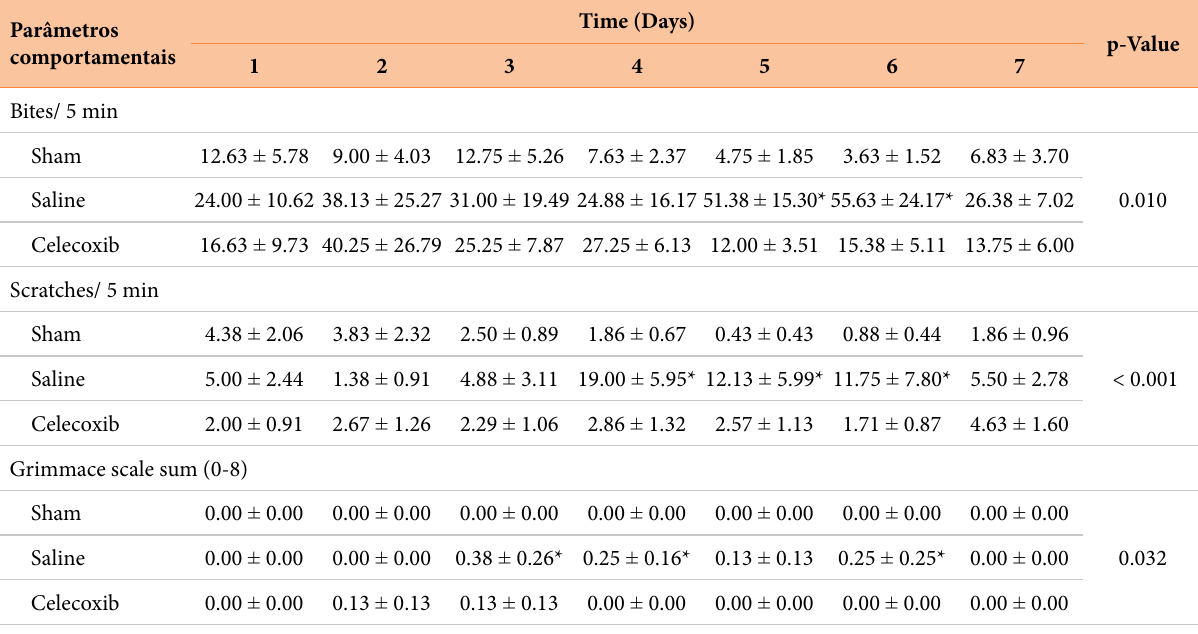
Table 1 - Temporal course of nociception assay, counting of bites/scratches, mensuration of Grimace scale and weight loss in rats treated with celecoxib (Eurofarma ® ) and exposed to experimental model of occlusal dental interference.